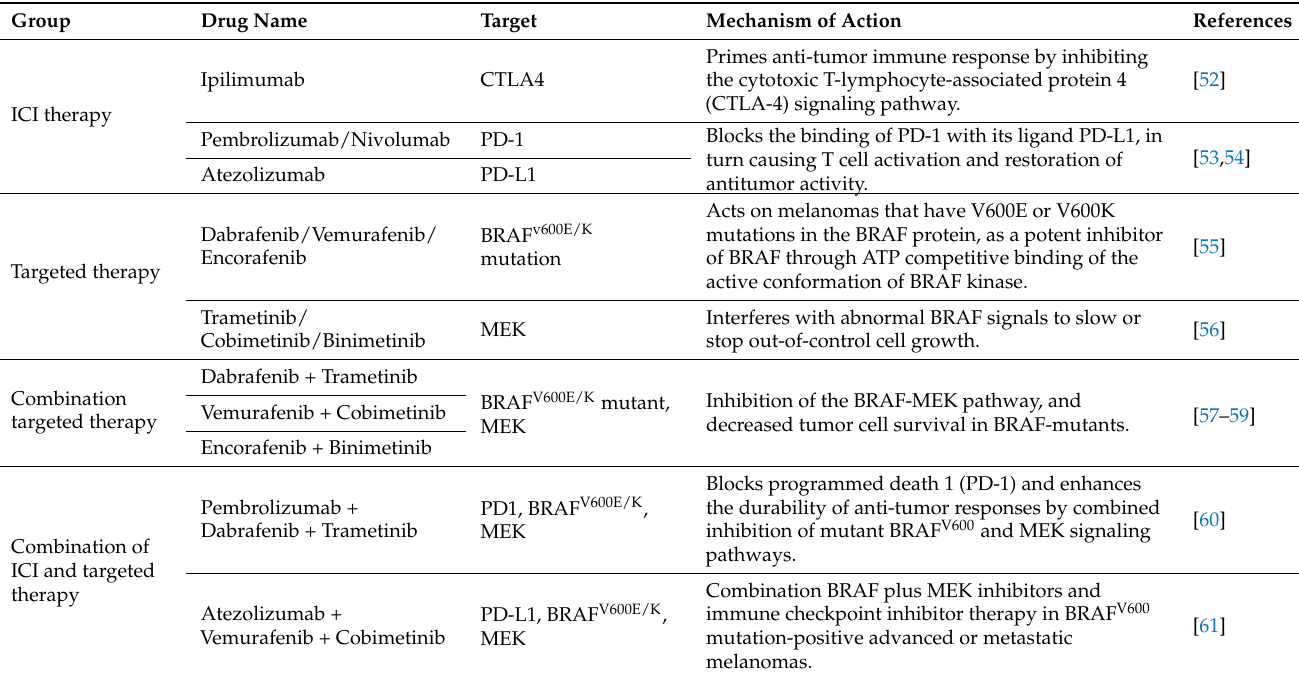
Table 1. Currently available treatment strategies for cutaneous